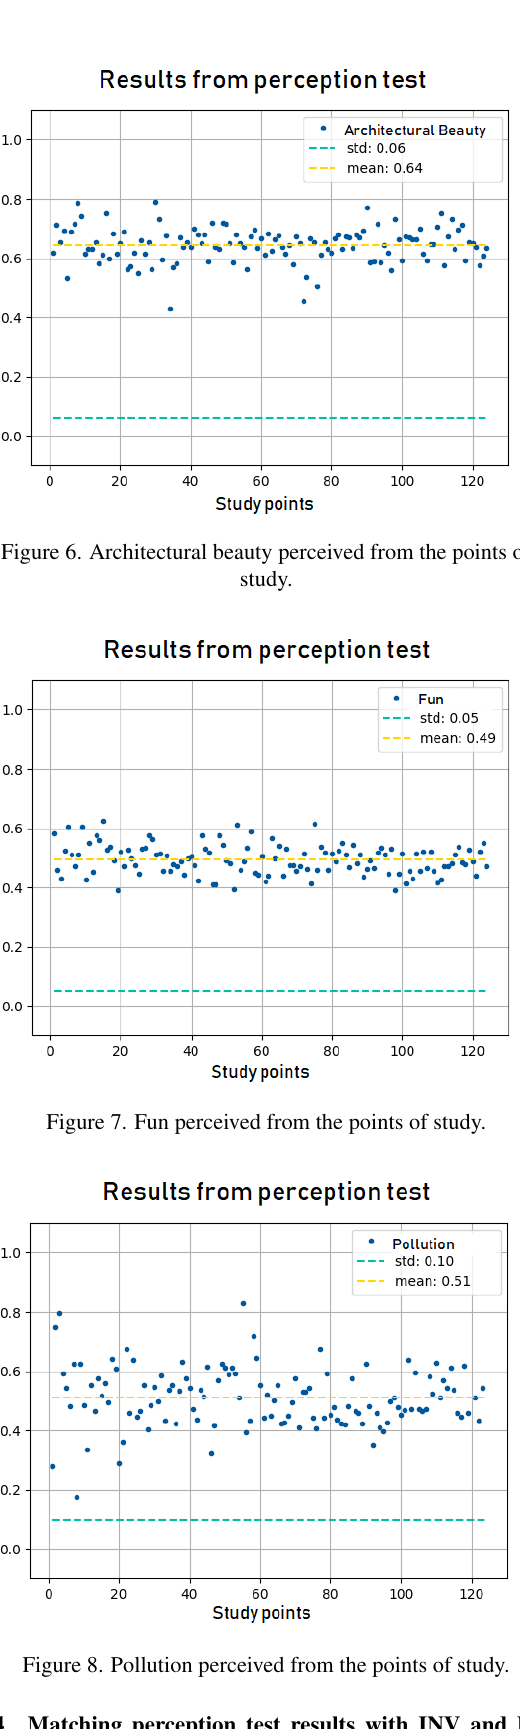
Figure 11. Relation between Architecture Beauty VS Number of establishments nearby. It can be seen that at lower Number of establishments, the higher perception of Architecture